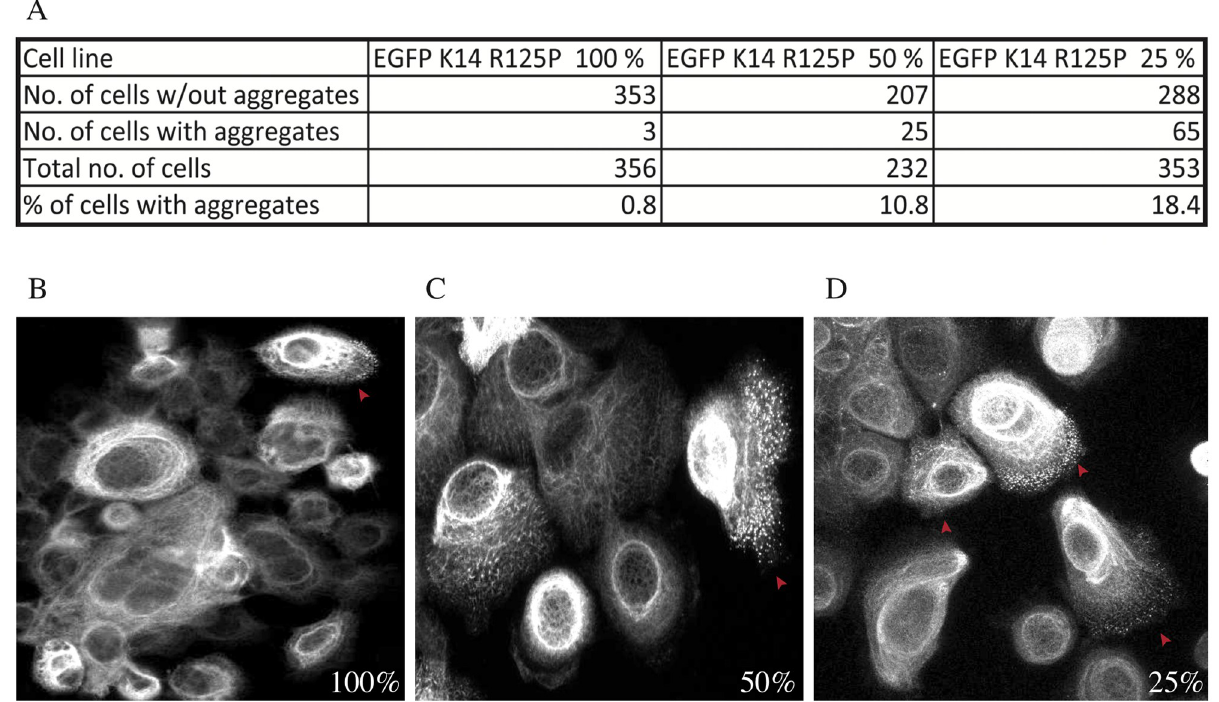
Fig 6. Quantification of aggregates in cells of EGFP-K14 R125P cell lines. (A) Summary of data, pointing out to the fact that the least cells with aggregates were seen in the 100% EGFP-K14 R125P cell line (0.8%), followed by the 50% one (10.8%), while the most cells with aggregates were seen in the 25% EGFP-K14 R125P cell line (18%). In the panels below are representative images (fields of view) of each of these cell lines (B-100%, C—50%, D —25%). The arrows point out cells that are representative for cells with aggregates.